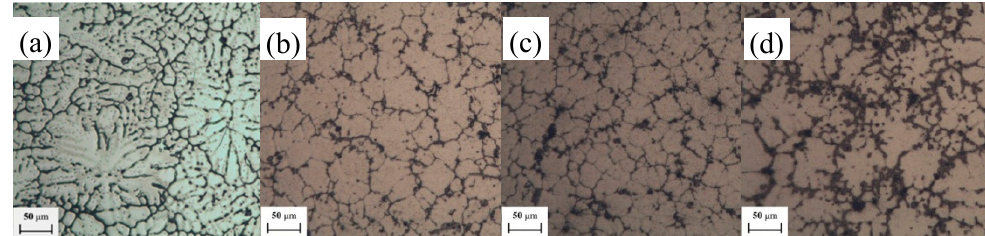
Figure 4. Microstructure of specimens cast at 720 °C: ( a ) 7075, ( b ) 3 wt. % TiB 2 /7075, ( c ) 4.5 wt. % TiB 2 /7075, and ( d ) 6 wt. % TiB 2 /7075.